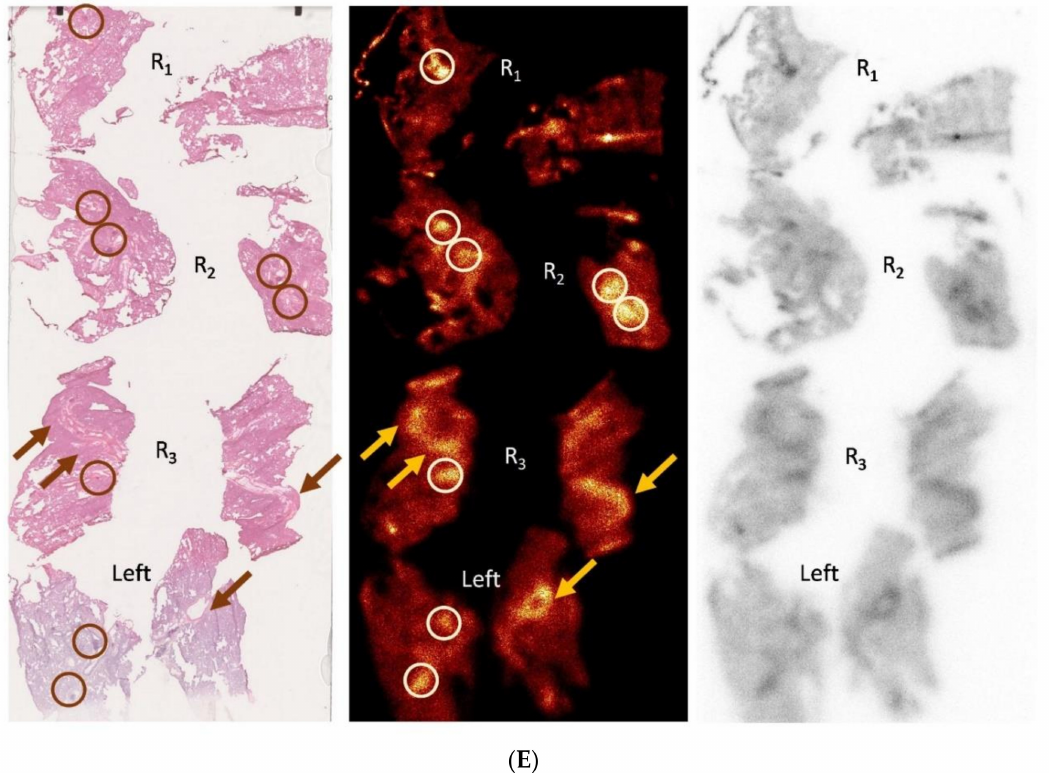
Figure 4. Longitudinal PET imaging in Group I, during 28 days of bleomycin-induced lung injury, using the novel PET tracer for assessment of non-cross-linked Collagen-I. ( A ) Representative PET images of lungs from rats challenged by i.t. administration of bleomycin (or saline as controls) on day 7, 14, 21, and 28 post-challenge. ( B ) Quantification of the total lung tissue signal uptake expressed as fraction uptake (total lung uptake of the injected dose [%ID]). The PET signal was assessed in di ff erent compartments, defined as high signal regions based on the TE SHORT and TE LONG , sequences from obtained MRI scans. ( C ) PET signal uptake from TE LONG defined lesions (yellow area) and surrounding area within the total Lung-ROI. ( D ) PET signal uptake within the TE SHORT defined lesions (blue) and surrounding area within the total Lung-ROI. ( E ) Autoradiography was performed in few of the animals to assess microscopic tracer uptake directly after the PET scan. One time point (day 21) from the bleomycin-challenged group is presented here. Lungs R1–R4 are Right lung lobes from the top section and downwards. Left referring to the left lung lobe. Enhanced signal uptake of CBP-Cu 64 is indicated by arrows (in the case of long streaks of signal) or encircled (in the case of focused area), where also fibrotic tissue is observed in close proximity to healthy tissue and vessel-airway